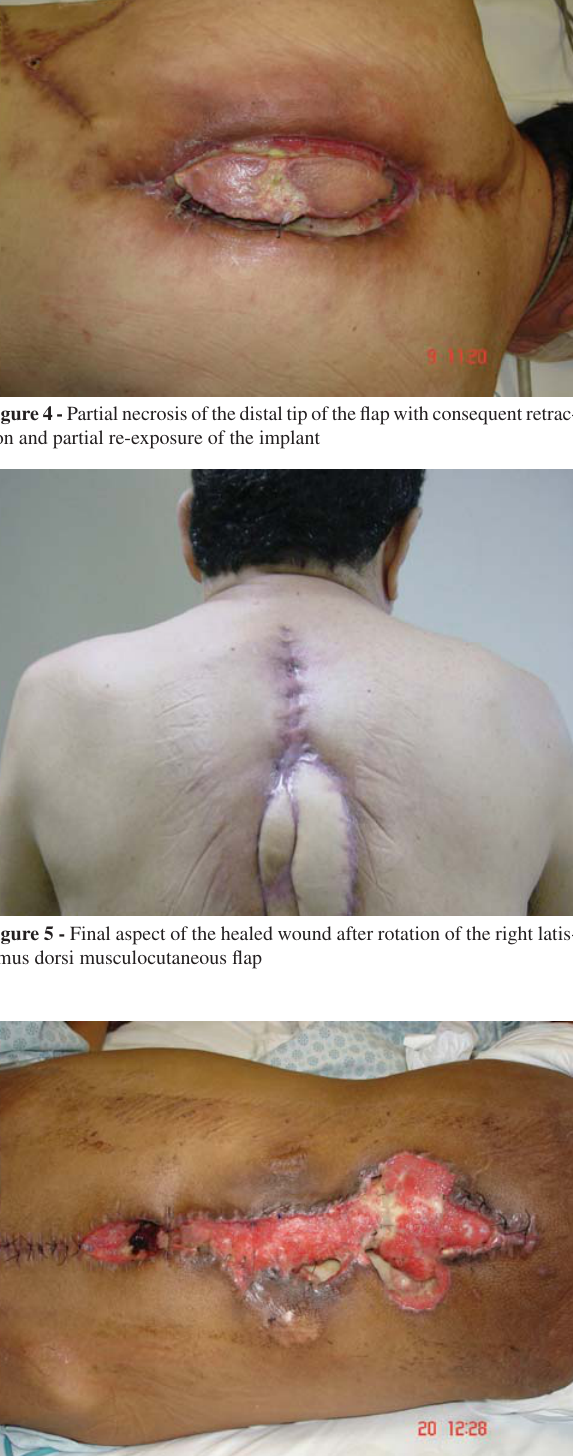
Figure 6 - Early massive dehiscence of the incision after spine surgery